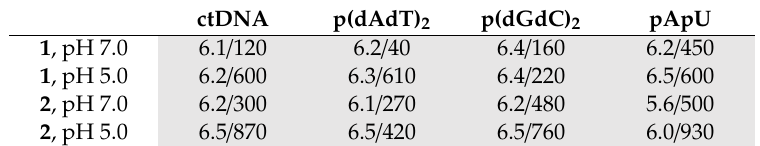
Table 2. Binding constants and spectroscopic properties of complexes ( a log K s / b Int) of conjugates 1 and 2 with ds-polynucleotides calculated by processing fluorimetric titrations ( c = 5 × 10 − 7 M), at pH = 7.0 and pH = 5.0, sodium cacodylate bu ff er, I = 0.05